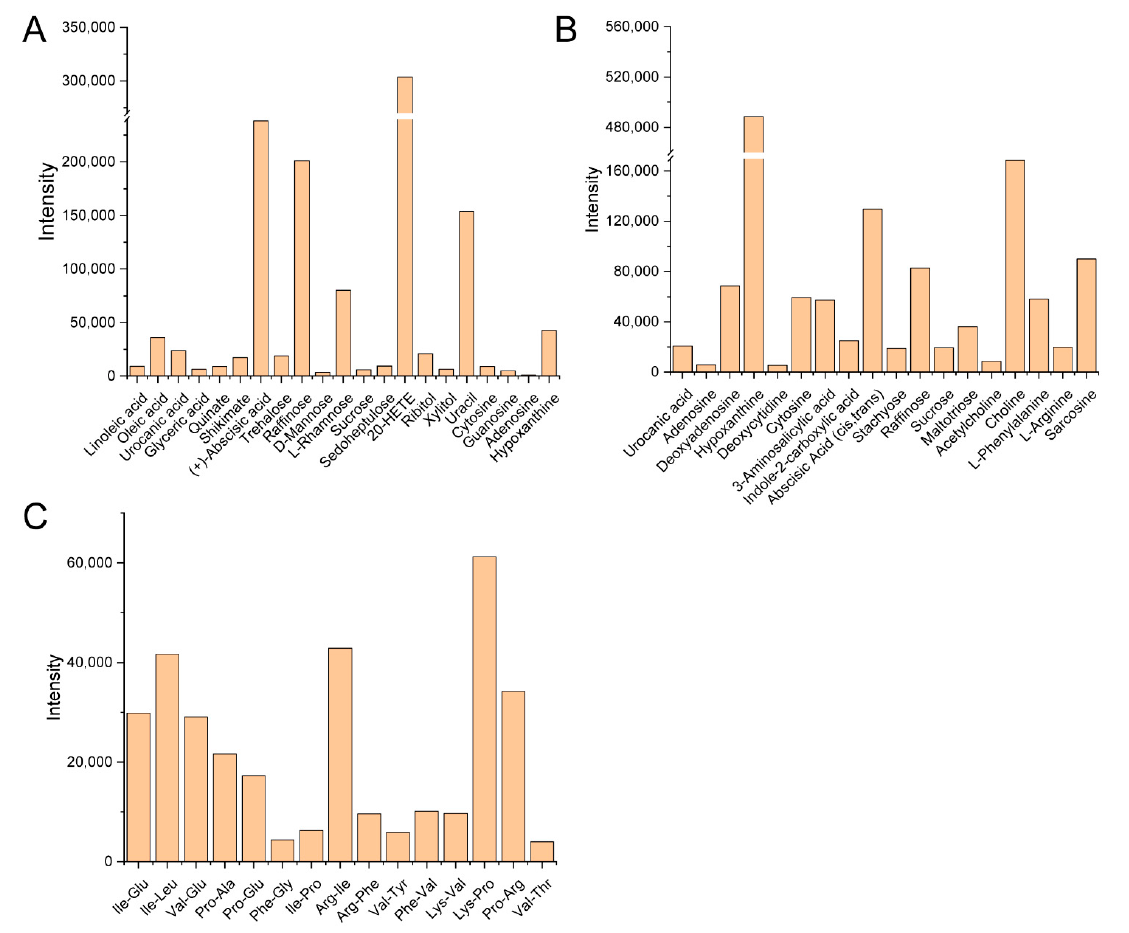
Figure 3. The relative content of the components in the guttation. ( A ) Components identified in a cationic state; ( B , C ) Components identified in an anionic state.